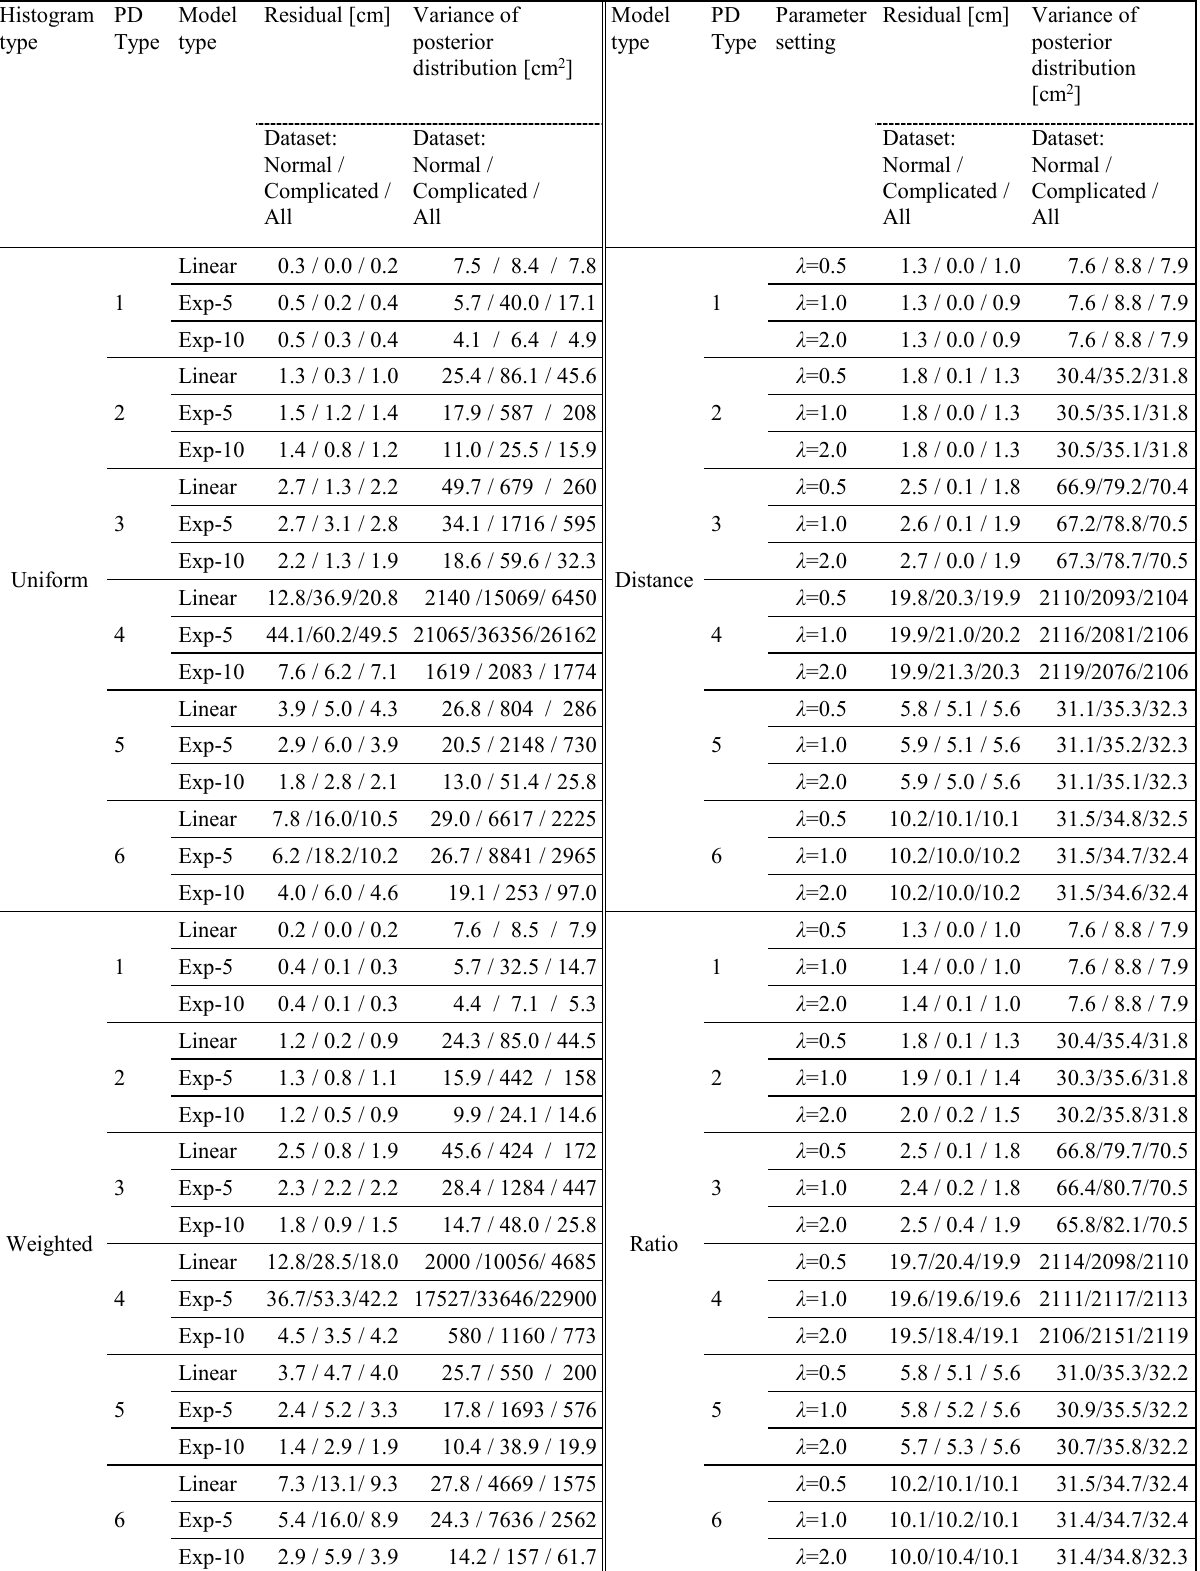
Table 9. Sensitive analysis on colour models Table 10. Sensitive analysis on range